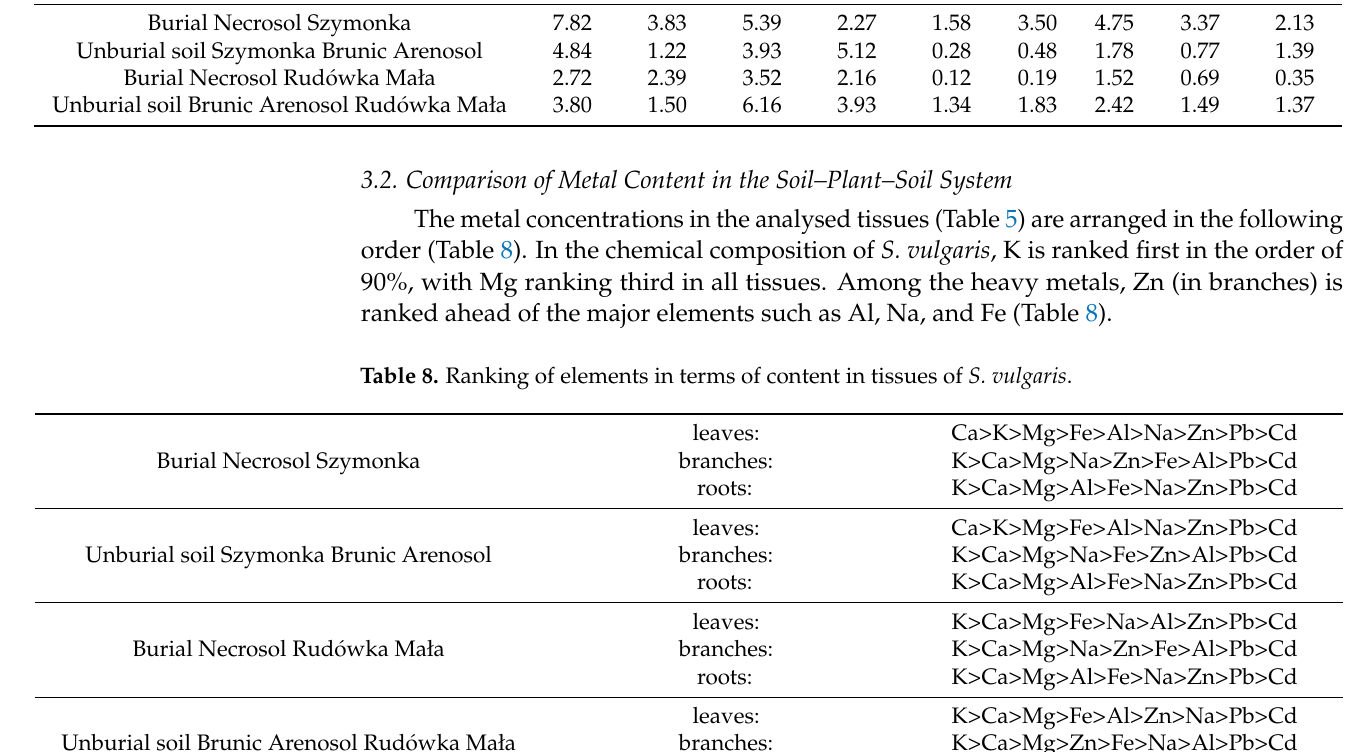
Table 7. Translocation factor (TF) within studied samples (aboveground part of plant/root). Localization